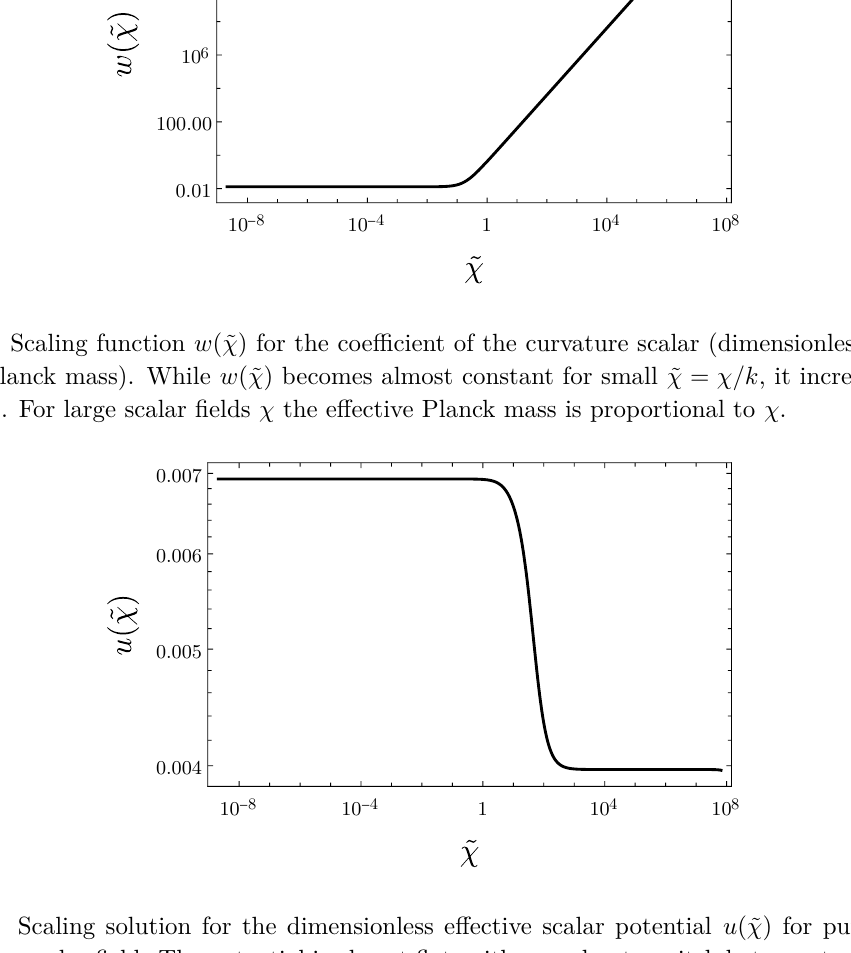
Figure 2 . Scaling solution for the dimensionless effective scalar potential u (˜ χ ) for pure gravity coupled to a scalar field. The potential is almost flat, with a moderate switch between two plateaus at the value of ˜ χ = χ/k characteristic for the